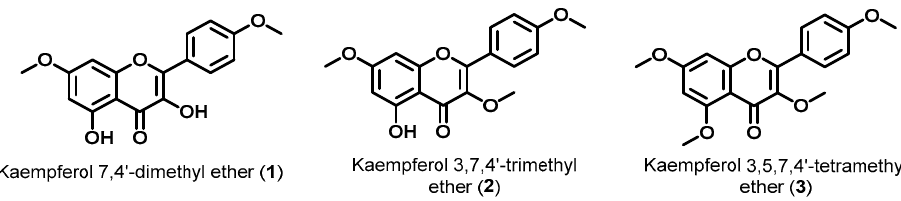
Figure 1. The three flavonols isolated from Hedychium gardnerianum Figure 42. The three flavonols isolated from Hedychium gardnerianum .